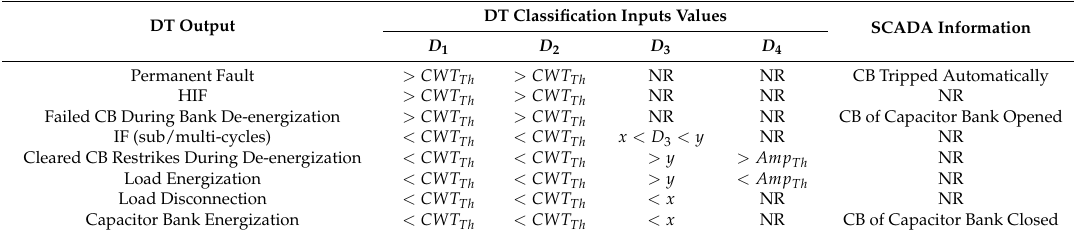
Table 4. The required values for all DT inputs with SCADA communication to identify the issue.